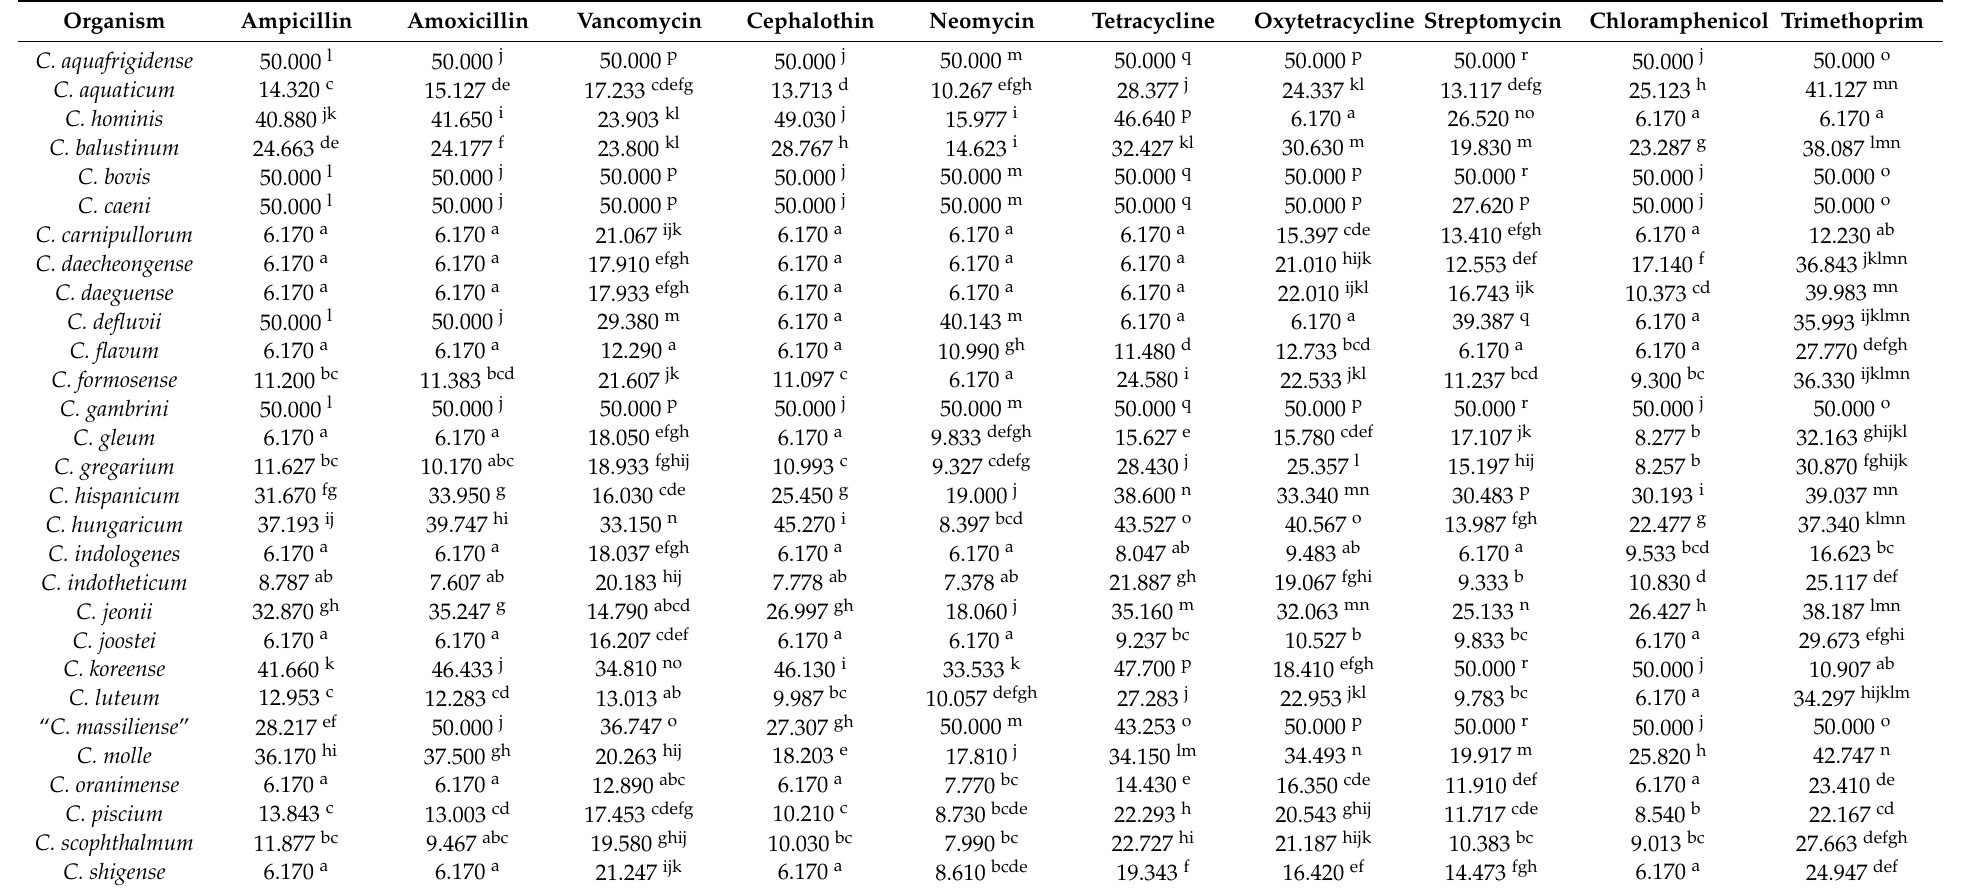
Table 3. Resistance/susceptibility patterns for the 37 Chryseobacterium species and Elizabethkingia meningoseptica used in this study. Values are the zone sizes given in millimetres. Means with different superscripts in the same column differed significantly ( n =